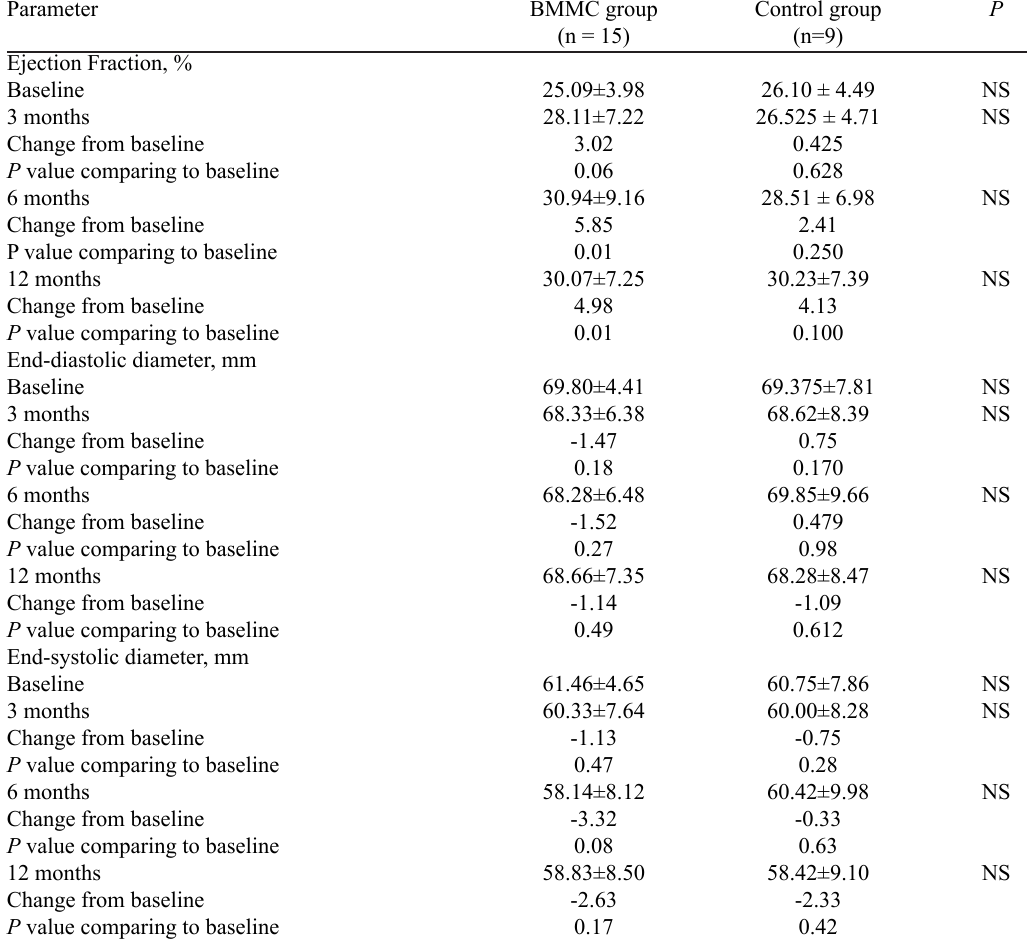
Table 4. Left ventricular volumes and function as assessed by echocardiography